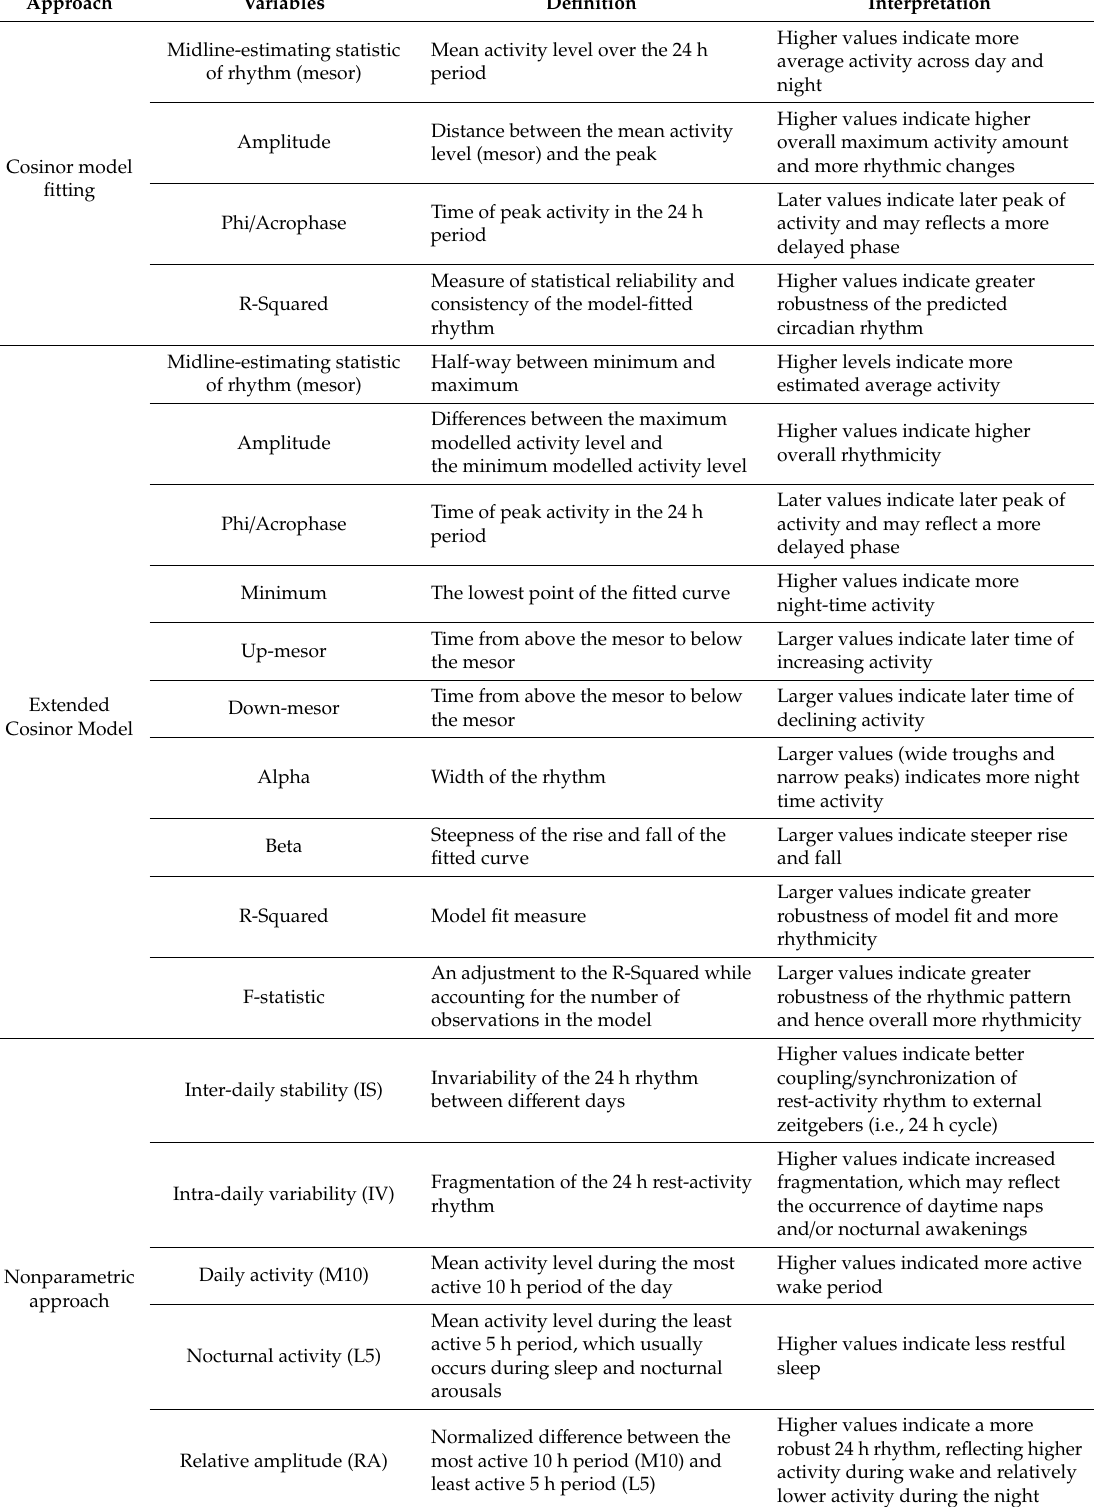
Table 1. Circadian outcome variables derived from traditional parametric and non-parametric